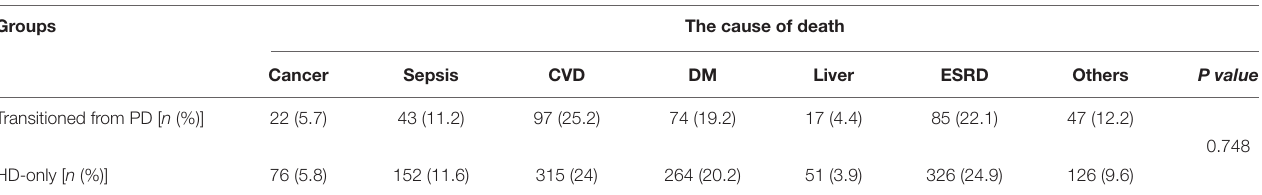
TABLE 3 | The causes of death in hemodialysis patients.